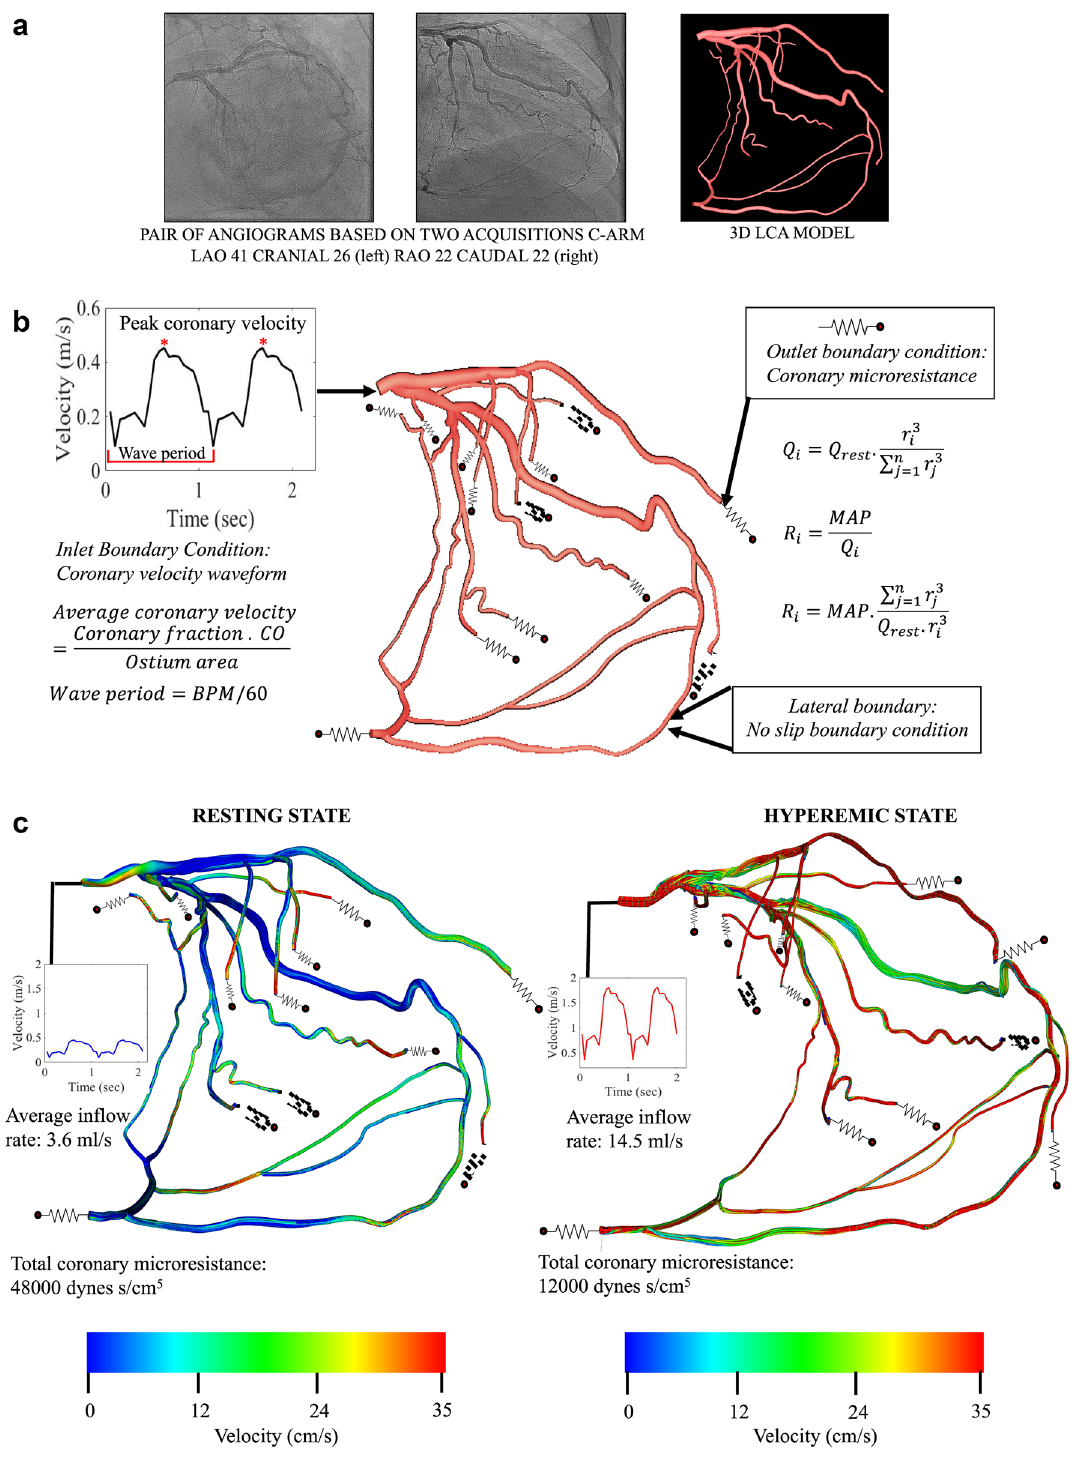
Figure 1. Central illustration Computational fluid dynamic (CFD) methodology applied to biplane coronary angiography (CA) data in a left coronary circulation that supplies RCA vascular bed via collaterals. ( a ) Two biplane CA views at a particular angle for a left coronary arterial tree with collateral flow with the corresponding 3D reconstructed geometry. ( b ) CFD model of blood flow applied to the reconstructed geometry from ( a ). Boundary conditions are applied at the inlet (transient velocity waveform), outlet (lumped parameter for arterial microcirculation) and lateral surfaces (zero velocity or no slip boundary condition). ( c ) Modeling resting and hyperemic coronary circulation with a patient-data tuned velocity waveform and total coronary microresistance, 48000 dynes s/cm 5 and 12000 dynes s/cm 5 at resting and hyperemic states,